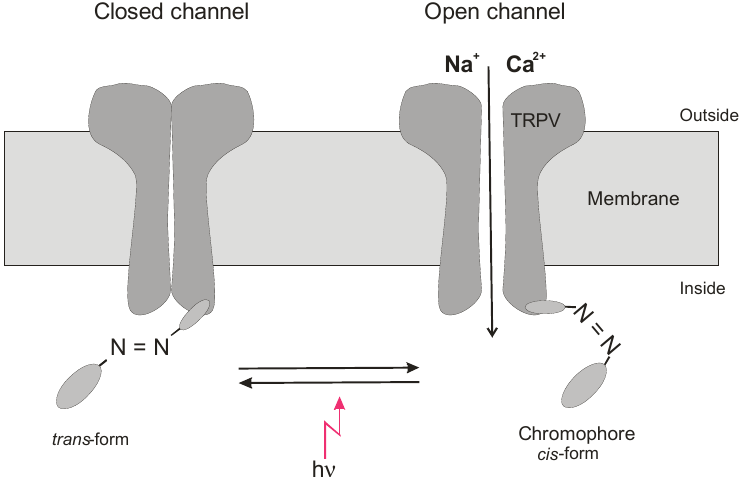
Figure 5. Modulation of TRPV channel gating by light-switched ligand. Putative modulation of an azo-chromophore between cis - and trans -form by light leading to activation of TRPV channel opening. As an example TRPV activation by the cis -form is